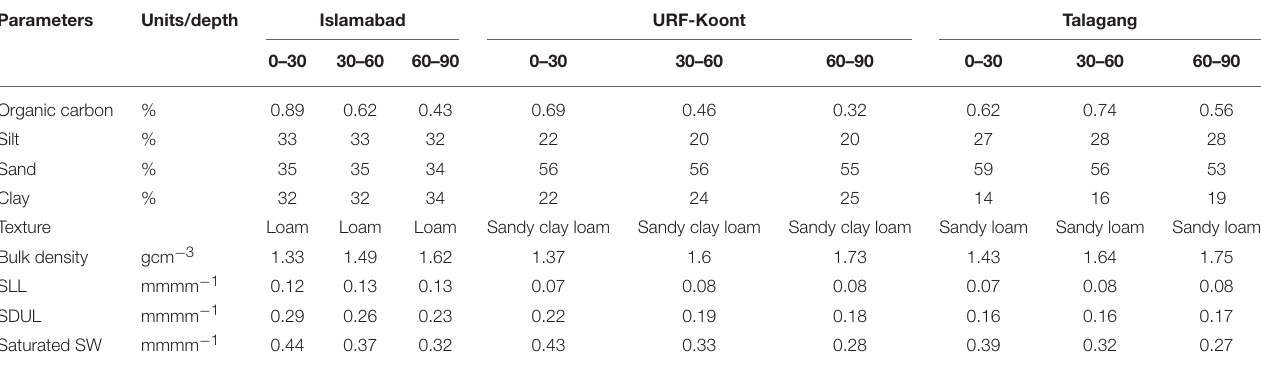
TABLE 1 | Soil physiochemical properties for three study sites. Parameters